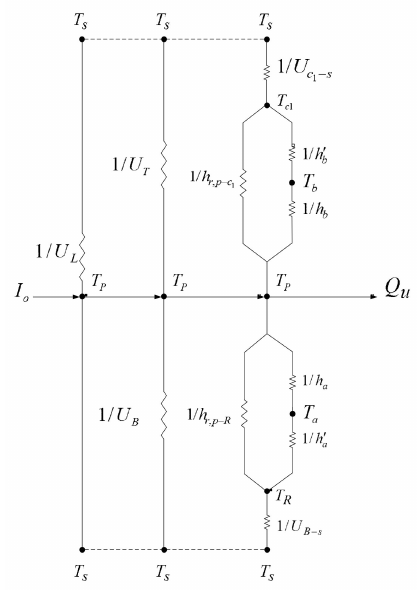
Figure 3. Schematic diagram of the thermal resistance network for W-ribs solar air